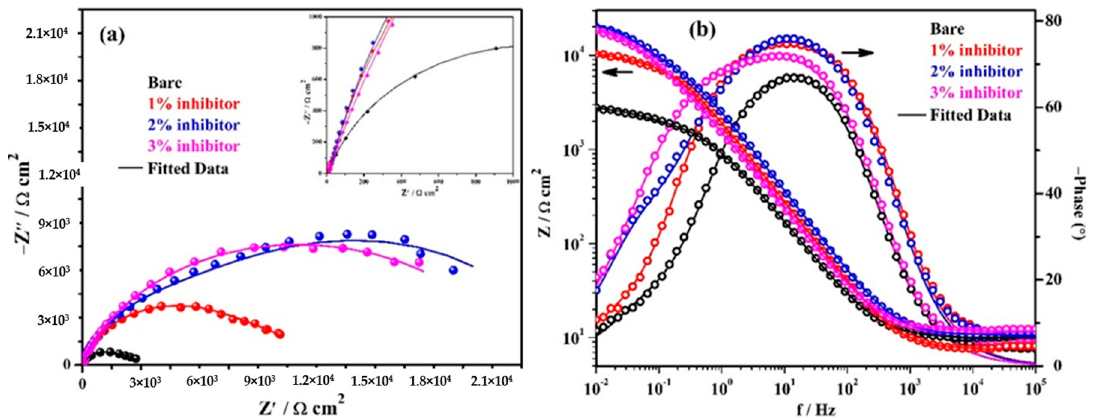
Figure 4. Electrochemical impedance spectroscopy (EIS) plots. ( a ) Complex plane impedance and ( b ) Bode spectra of steel rebars after 1 h of exposure in SCP + 3.5 wt% NaCl solution with and without inhibitor.